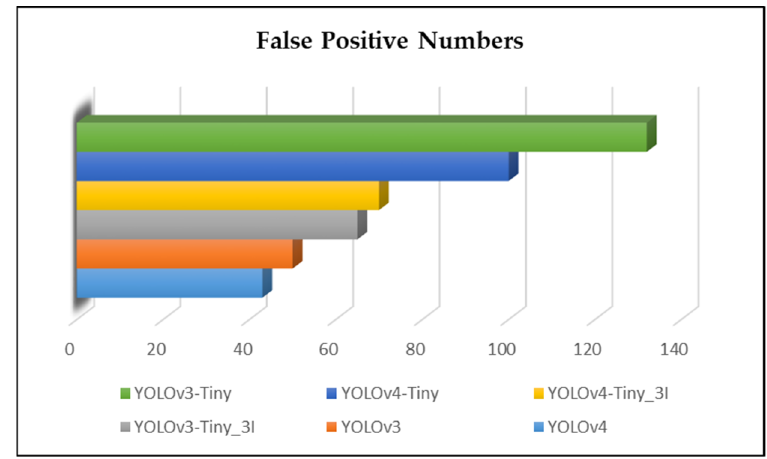
Figure 5. False-positive results in the weight files of the second experiment.